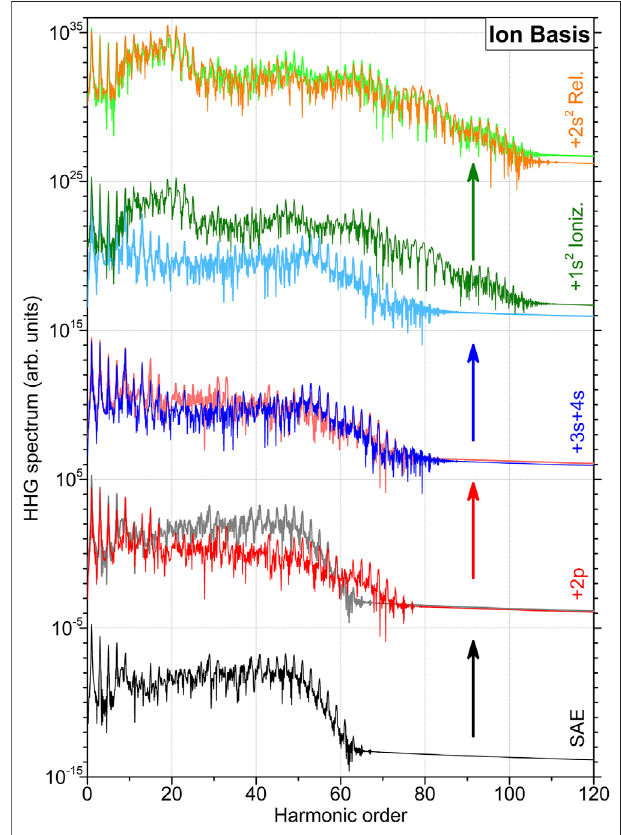
FIGURE 1 | High-order harmonic generation spectra of beryllium atom computedinthebasisset{ ϕ α }ofionicorbitals.Thecalculationsareperformed in a systematic series of improving approximations used to incorporate dynamics of the bound electrons (indicated at the right-hand vertical axis). For abetter comparison, the spectra in each row are compared with the ones calculated in the previous level of approximation (as indicated by the colored arrows) and are vertically shifted upwards by multiplying successively with 10 10 starting with the lowermost spectrum, obtained in the SAE approximation. The next two spectra (from bottom to top) are obtained within the 2FC approximation, by sequentially extending the basis set of discrete orbitals n ℓ + { } , fi rstwith2 p + andthenadditionallywith3 s + and4 s + .Thespectra shown in the two uppermost rows represent results obtained within the 2DC approximation, by additionally allowing fi rst 1 s 2 + ionization and then 2 s 2 +